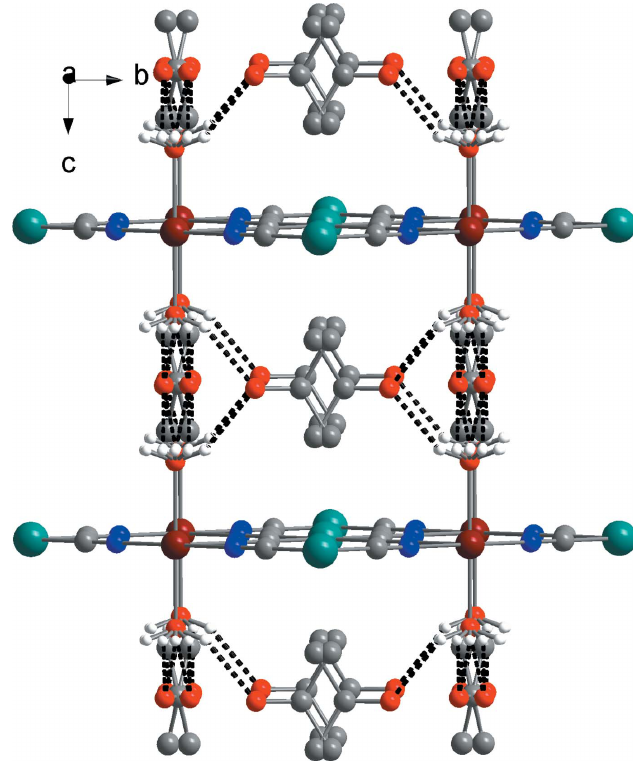
Figure 2 View of the crystal structure of the title compound in the bc plane showing the two-dimensional cyanometallic layers. Hydrogen bonds are shown as dashed lines. Acetone H atoms are omitted for